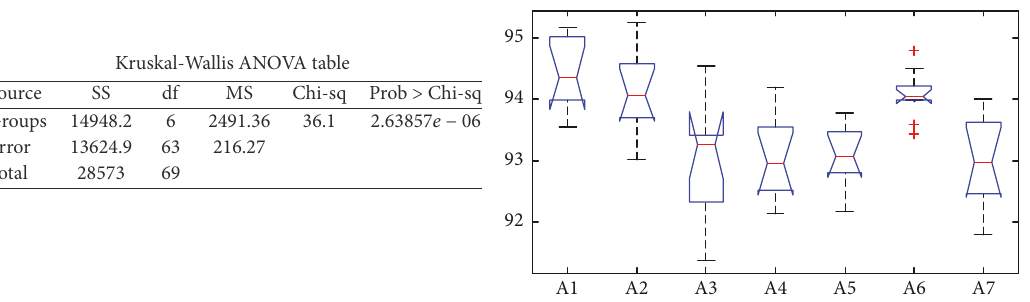
Figure 8: Nonparametric Kruskal-Wallis significance test